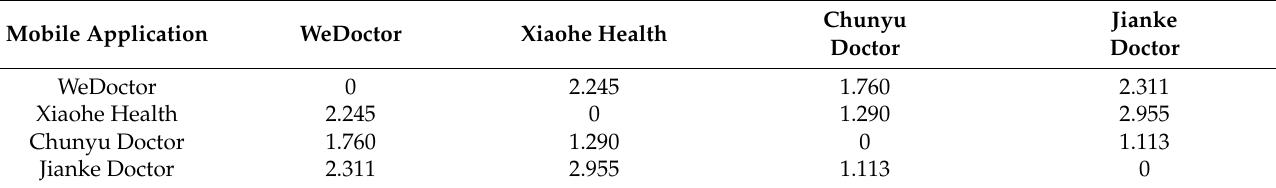
Table 2. Mobile application entity similarity